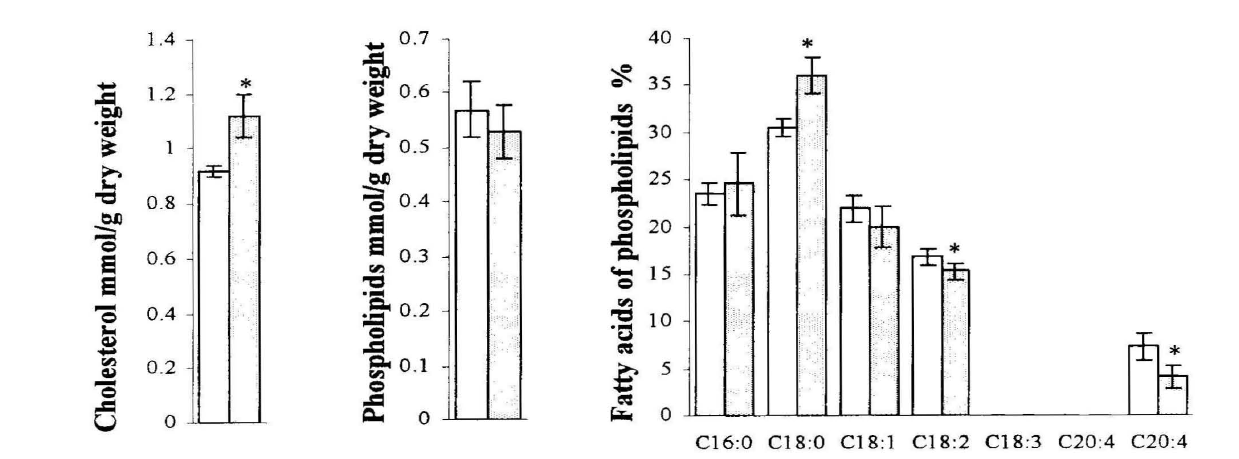
serotonin alone (see Fig. 3). We observed a decrease of palmitic and stearic and an increase of oleic, linoleic and 8,11,14,17,- arachidonic acid incorporation into phospholipids. The cholesterol content decreased, while the amount of phosp holipids increased in samples containing serotonin together with iproniasid. Iproniasid alone did neither alter the incorporation of fatty acids into phospholipids nor the content of phospholipids and